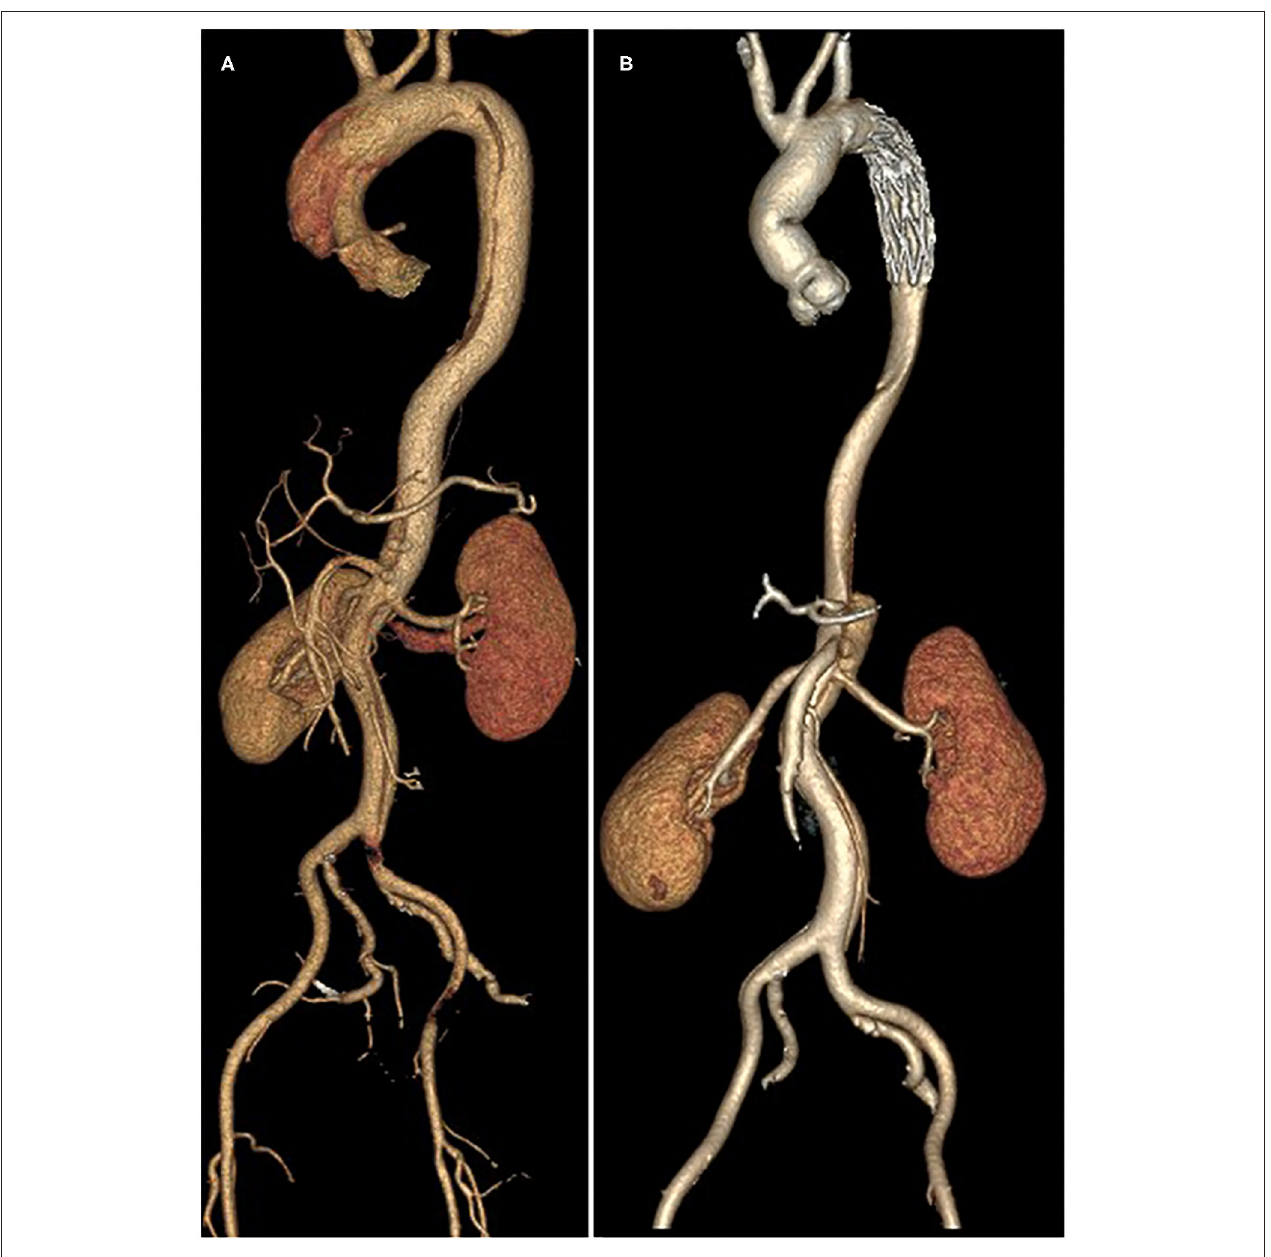
FIGURE 2 | Preoperative (A) and postoperative (B) computed tomography angiography reconstruction.